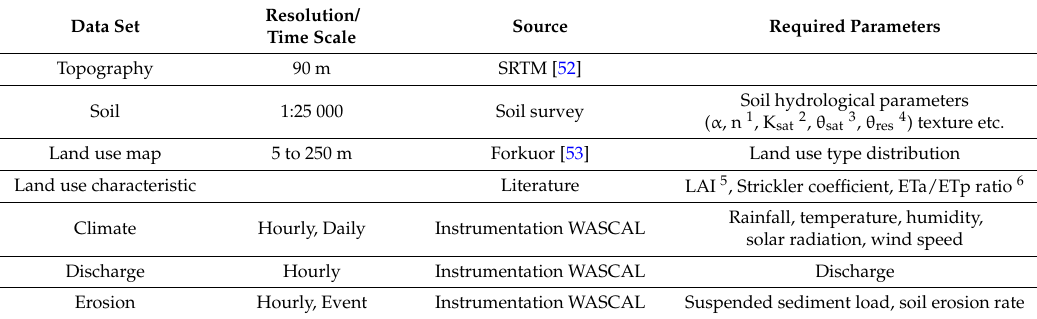
Table 4. Applied datasets and required inputs for SHETRAN.